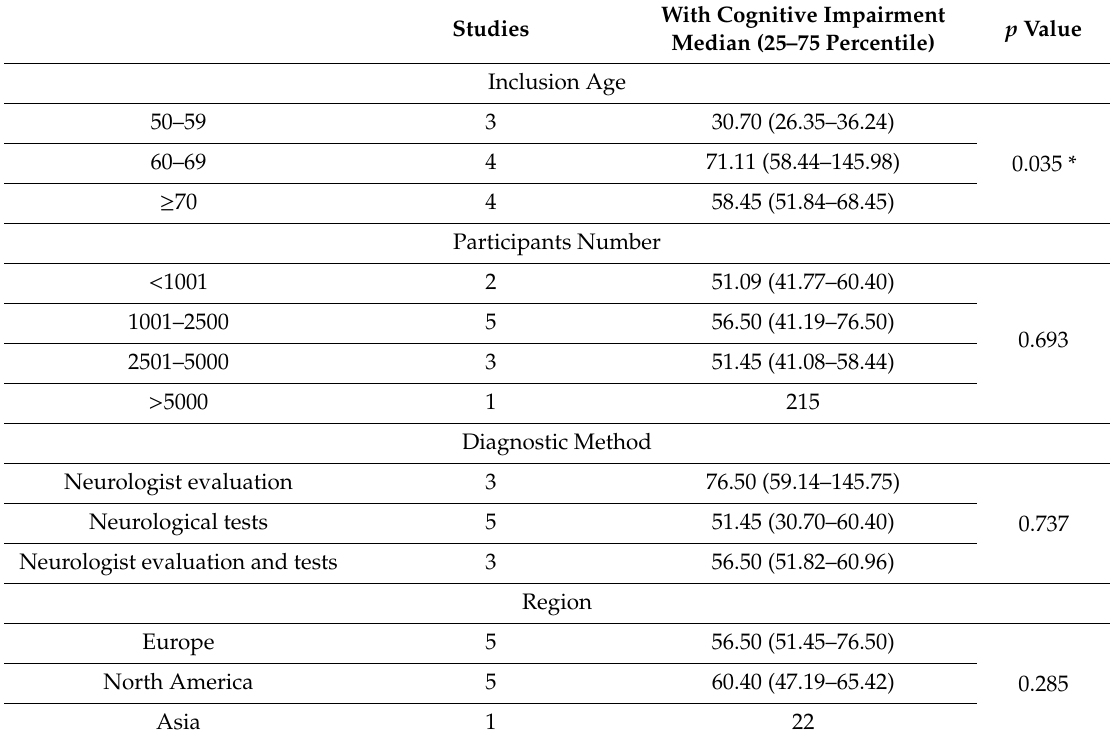
Table 2. Summary of cognitive impairment incidence as reported by the 11 studies included.